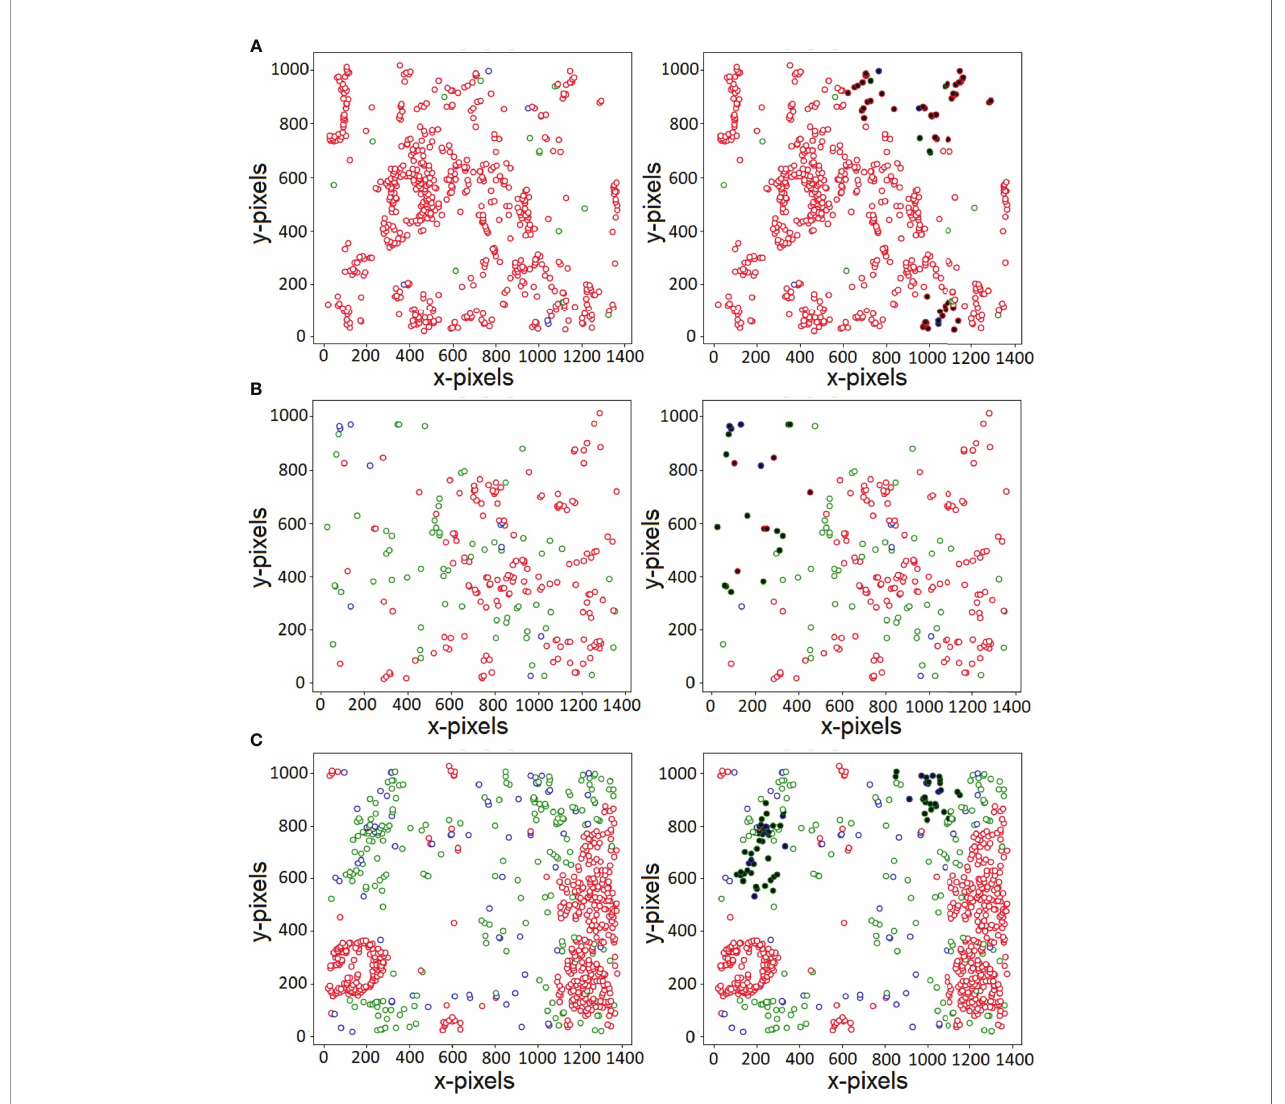
FIGURE 3 | Visualization of nuclei with large attention weights for three sample PDAC histopathology images (A – C) . Red, green and blue colors indicate the three types of labels - Epithelial, CTL and Treg, respectively. The cells with large attention weights likely belong to the interface of two or more cell types, indicating patterns that govern the various class